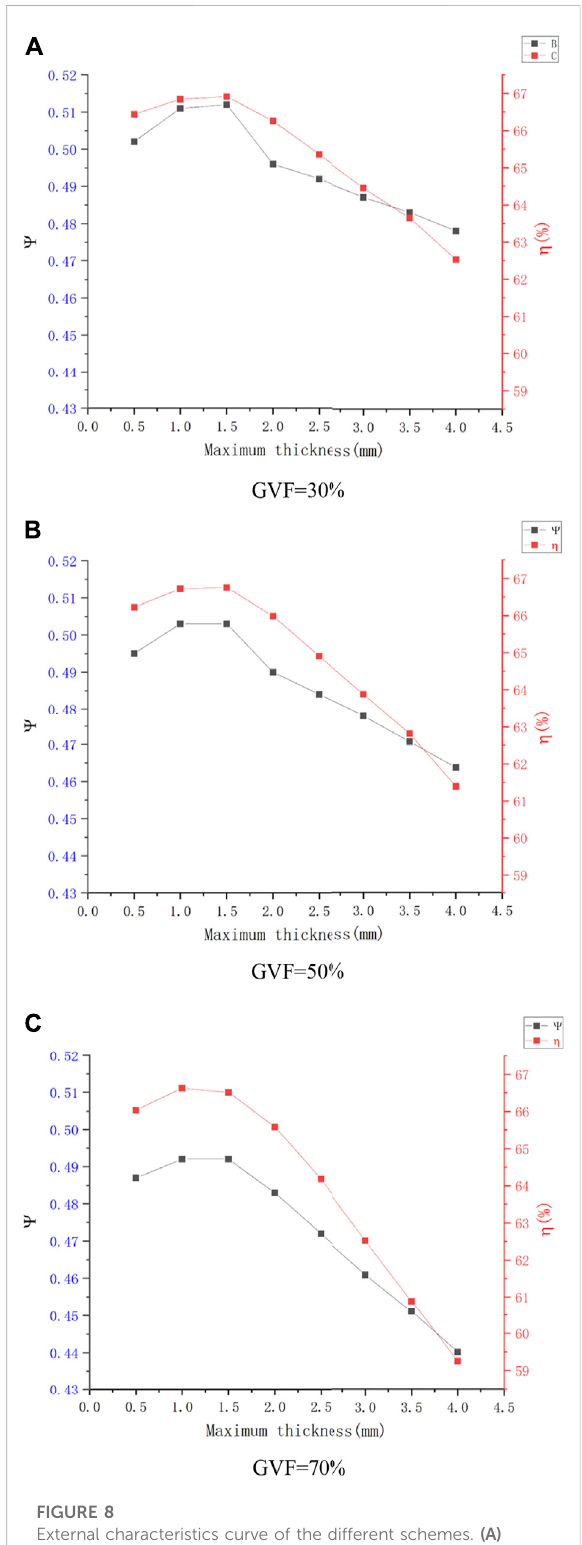
FIGURE 8 External characteristics curve of the different schemes.